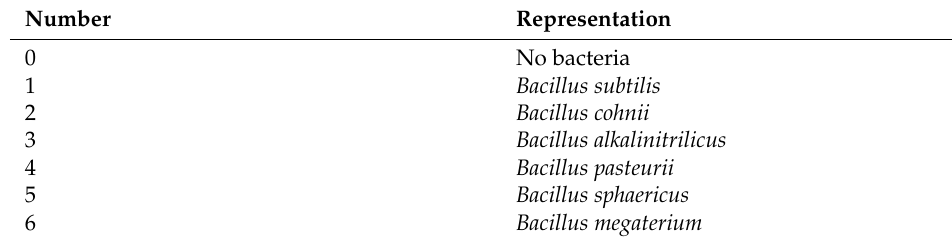
Table A2. Types of bacteria.